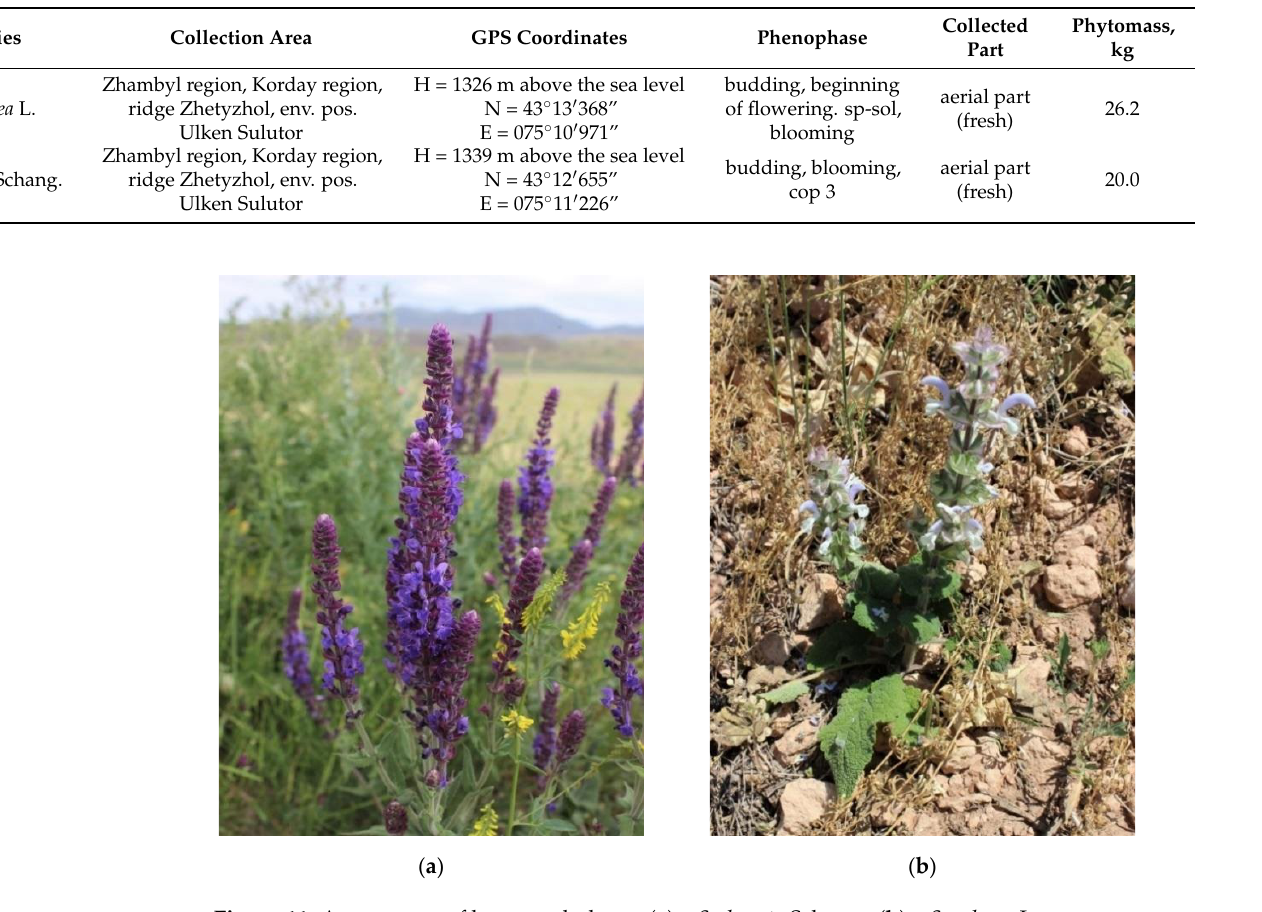
Figure 11. Appearance of harvested plants: ( a )— S. deserta Schang., ( b )— S. sclarea L. After the collection and initial treatment of plant materials (cleaning, drying and